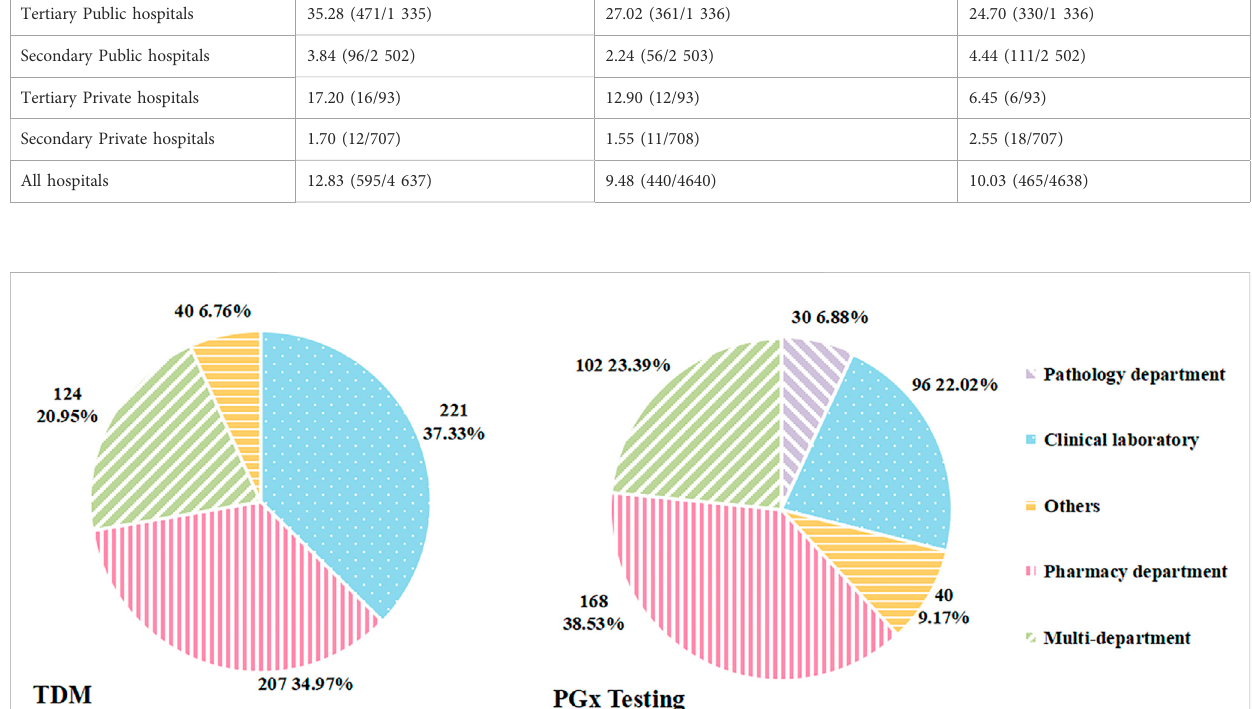
FIGURE 2 The proportion of different departments in charge of TDM and PGx